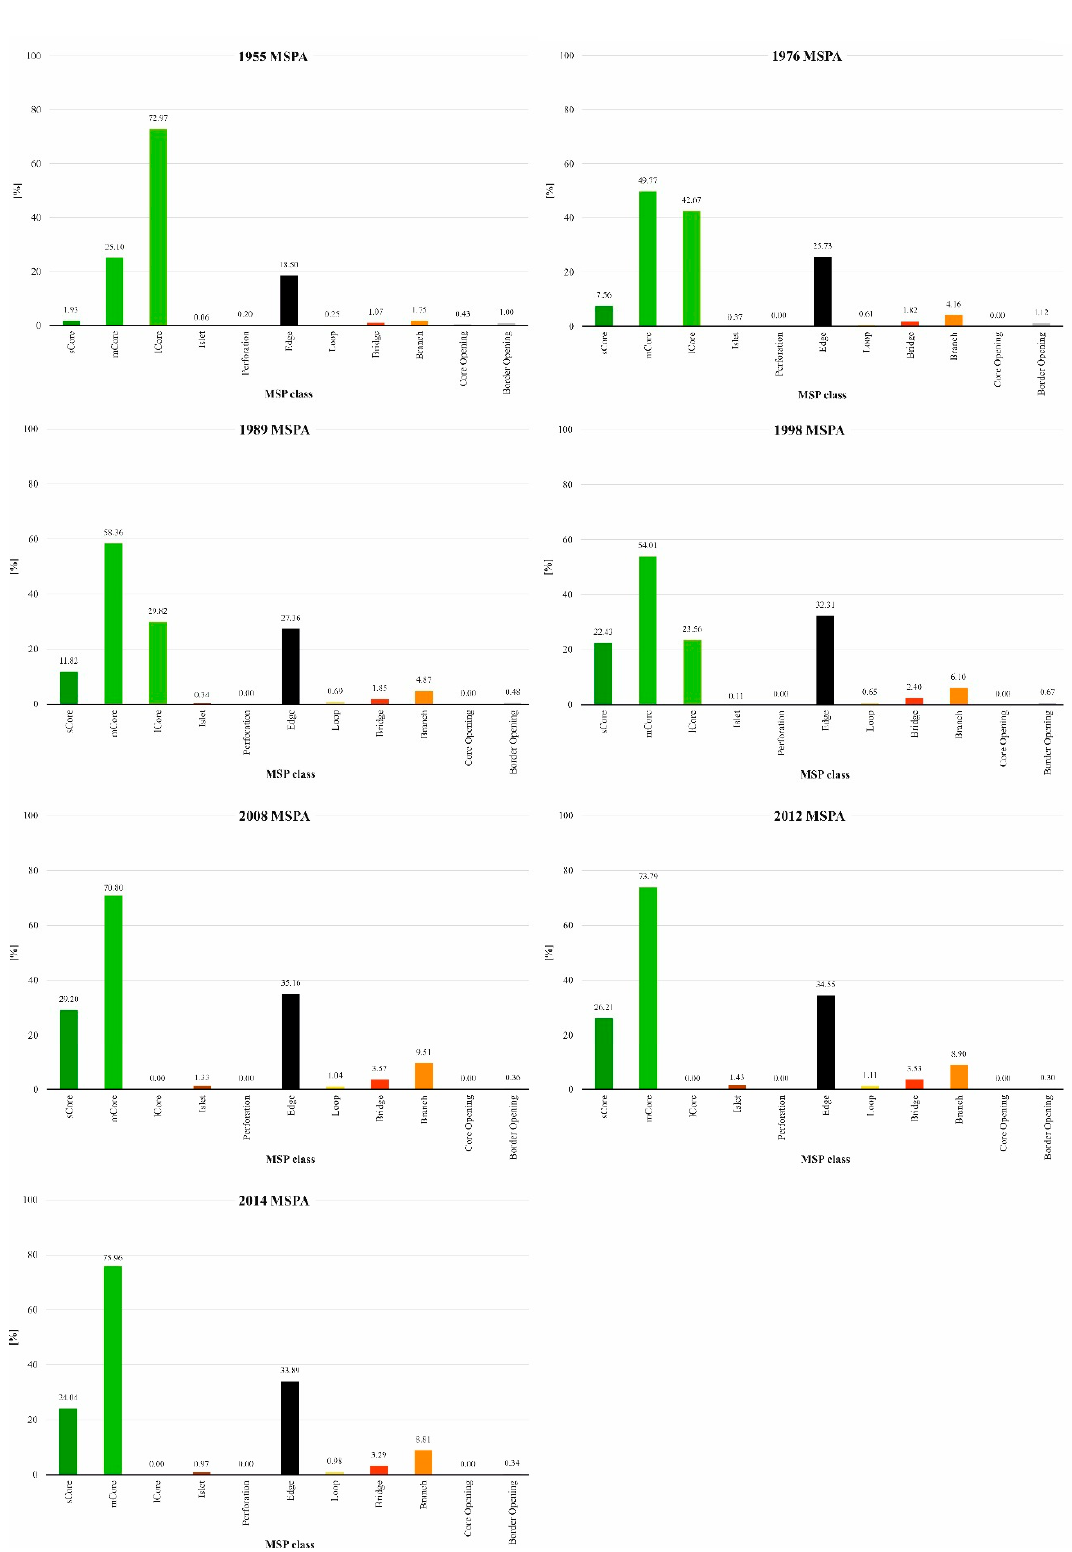
Figure A2. Morphological spatial pattern analysis (MSPA) results in terms of the relative importance of each class in the composition of the foreground for each investigated year and expressed as a percentage.